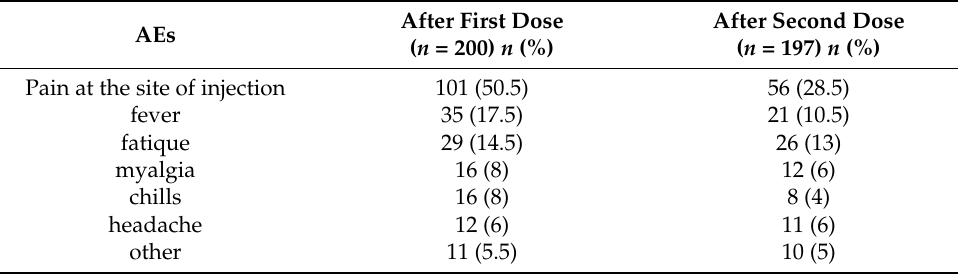
Figure 3. Side effects reported by PAH/CTEPH patients after COVID-19 vaccination. Thirty-three percent of the vaccinated patients had no side effects after receiving both the first and second doses of the COVID-19 vaccines. Side effects in vaccinated patients were more common after the first than the second doses (61% vs. 40.5% respectively, p = 0.01). The most frequently reported adverse events after the first doses were pain at the site of injection (50.5%), fever (17.5%), fatigue (14.5%), myalgia (8%), chills (8%), and head- ache (6%). The most common AEs after administration of the second doses of the vaccines were pain at the site of injection (28.5%), fever (10.5%), fatigue (13%), myalgia (6%), head- ache (6%) and chills (4%). The most frequent side effects after the first and second doses of vaccination against COVID-19 in PAH/CTEPH patients are presented in Table 3. Table 3. The most frequent side effects reported by PAH/CTEPH patients after the first and second doses of vaccination against